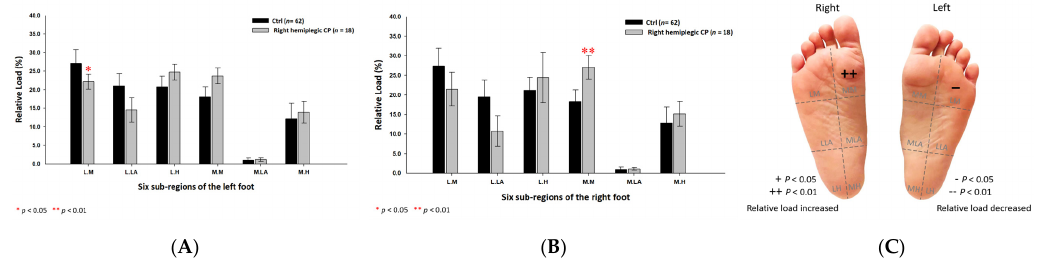
Figure 8. The percentage of six subregional relative loads of ( A ) left and ( B ) right feet in total students during static stance. The changes in pressure distribution are illustrated in ( C ) foot plantar diagram. Significant differences between the control group and the right hemiplegic CP group were determined as * p < 0.05 and ** p < 0.01.